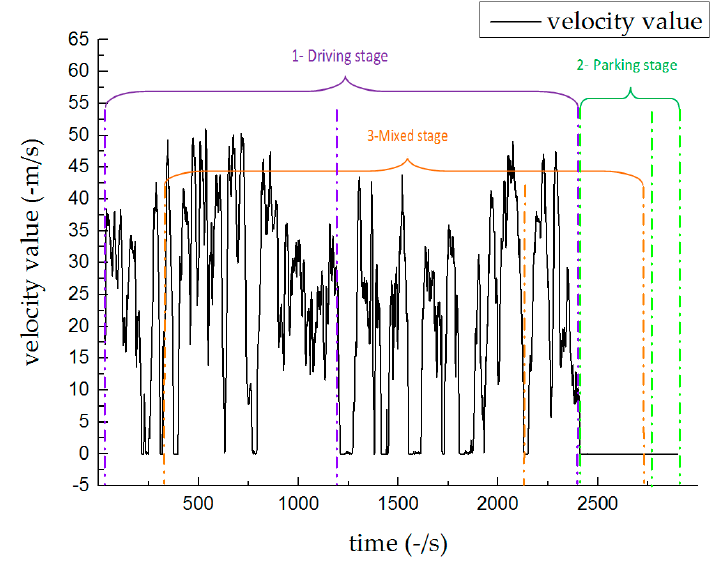
Figure 3. Experiment 1: Vehicle driving trajectory.